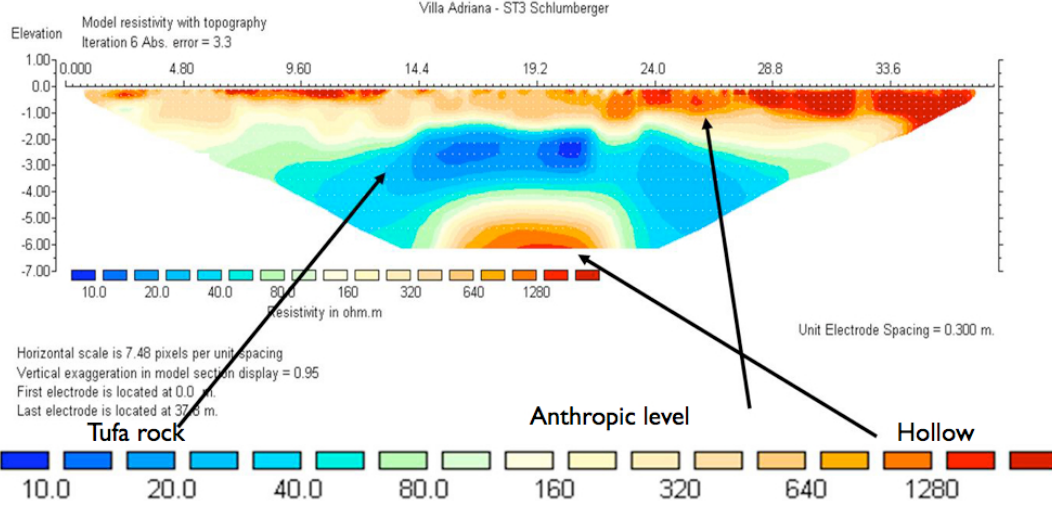
Fig. 12. Model resistivity of our survey (A. M. Marras).